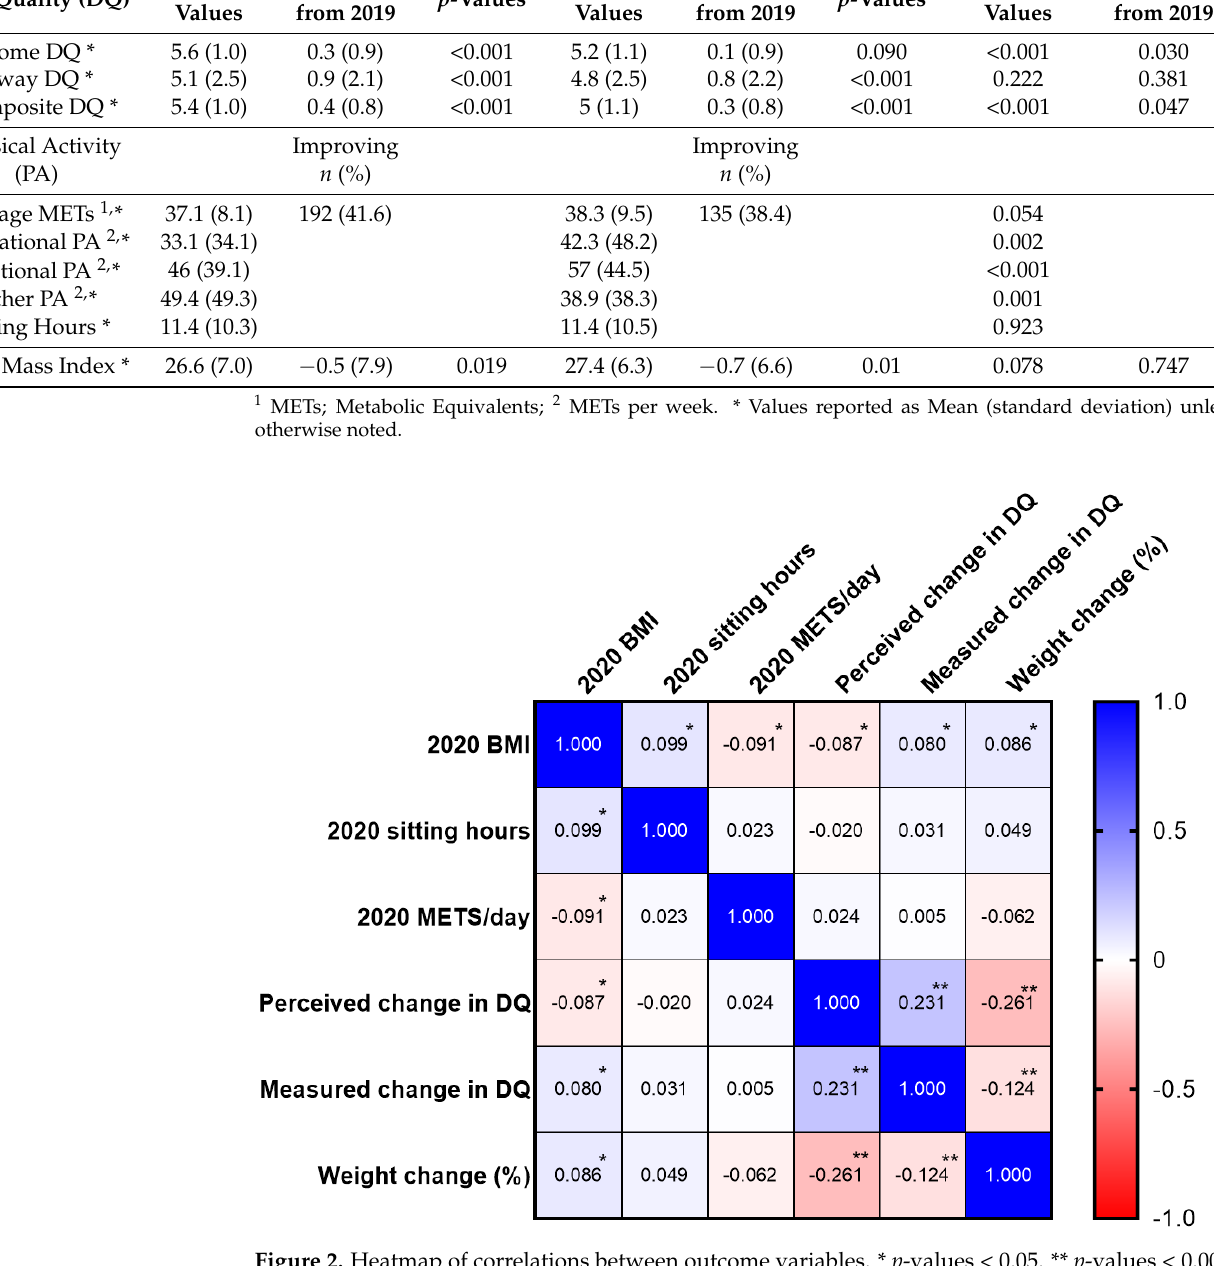
Figure 2. Heatmap of correlations between outcome variables. * p -values < 0.05. ** p -values < 0.001. Total Daily METs did not differ between individuals with and without obesity; how- ever, those with BMI < 30 reported greater Rec-PA ( p < 0.001) and less sitting time ( p = 0.019) than those with obesity in 2020 (Figure 3). Additionally, participants with obesity reported greater weight loss (mean wt change: − 2.64 kg ± 9.31 kg) than those with BMI < 30 (mean wt change: 0.1263 kg ± 6.42 kg) from 2019–2020 ( p < 0.001).